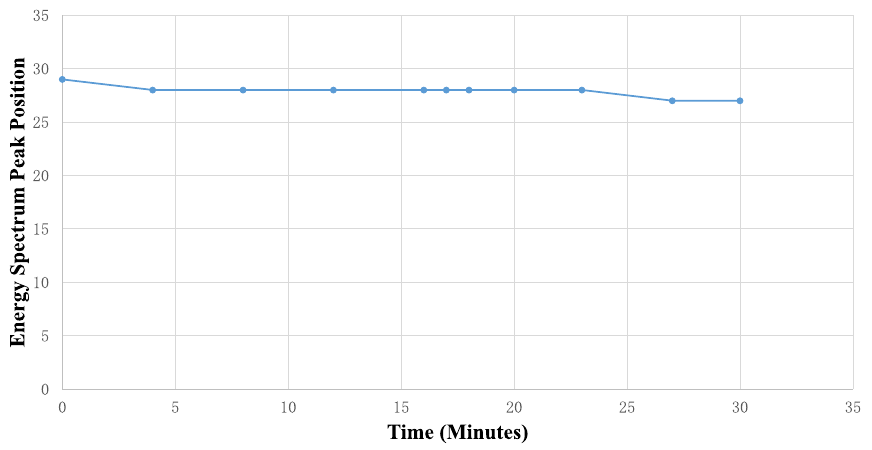
Fig. 9 The energy spectrum peak position of the DP-PET system over